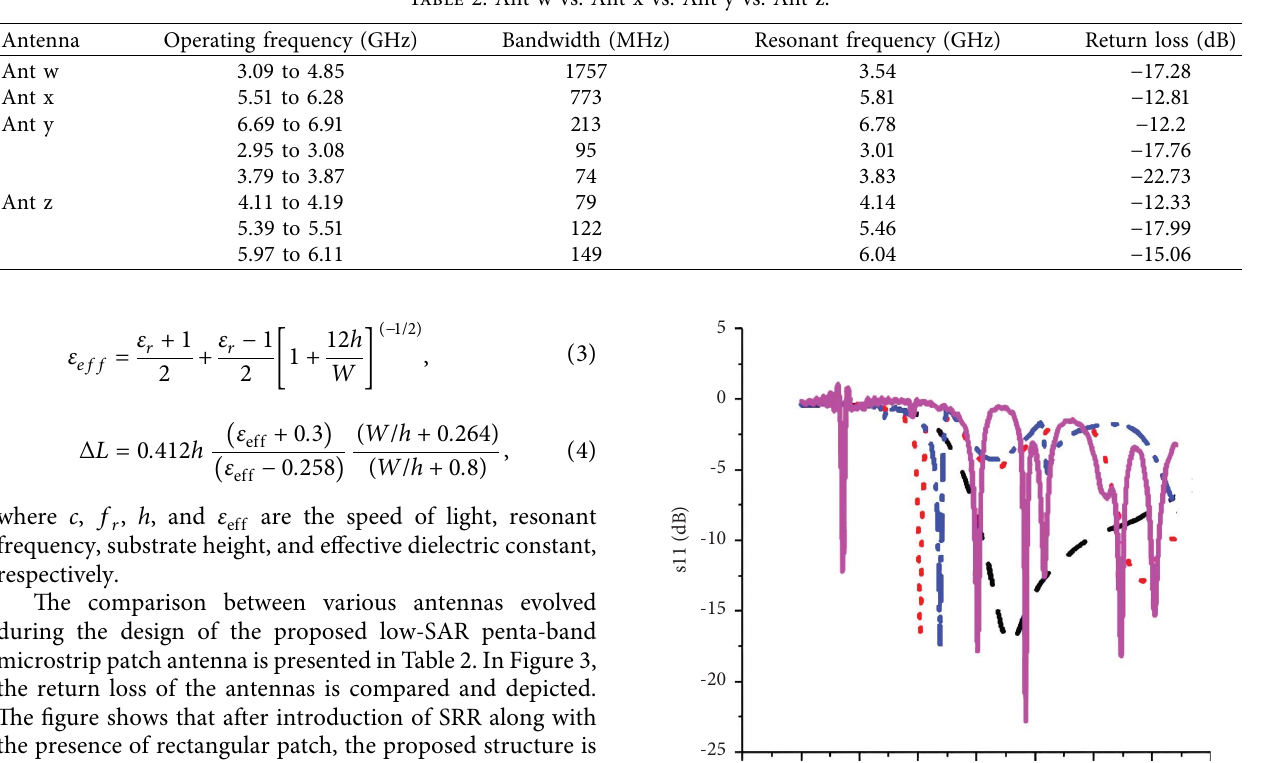
Table 2: Ant w vs. Ant x vs. Ant y vs. Ant z.